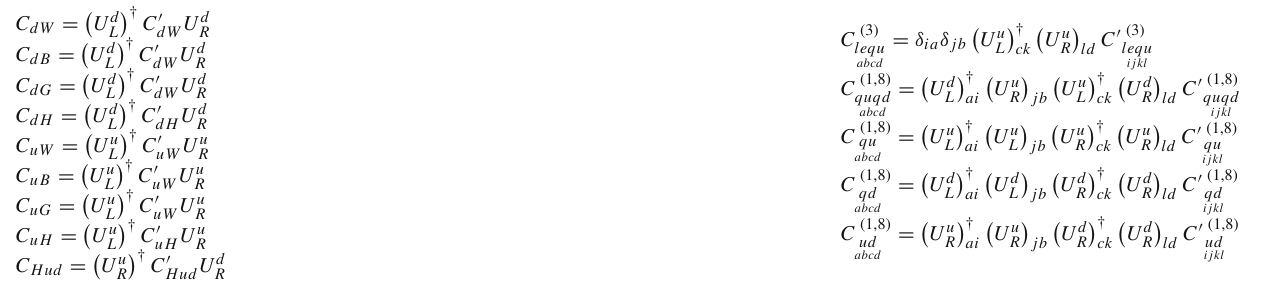
Table 2 Definitions of Wilson coefficients of fermionic operators used in this work. We suppress flavor indices whenever their contraction is non-ambiguous. (Un)primed coefficients denote the ones in the (mass) gauge basis. The specific form of the U unitary matrices, needed to the transformation to the mass basis, depends on the specific choice